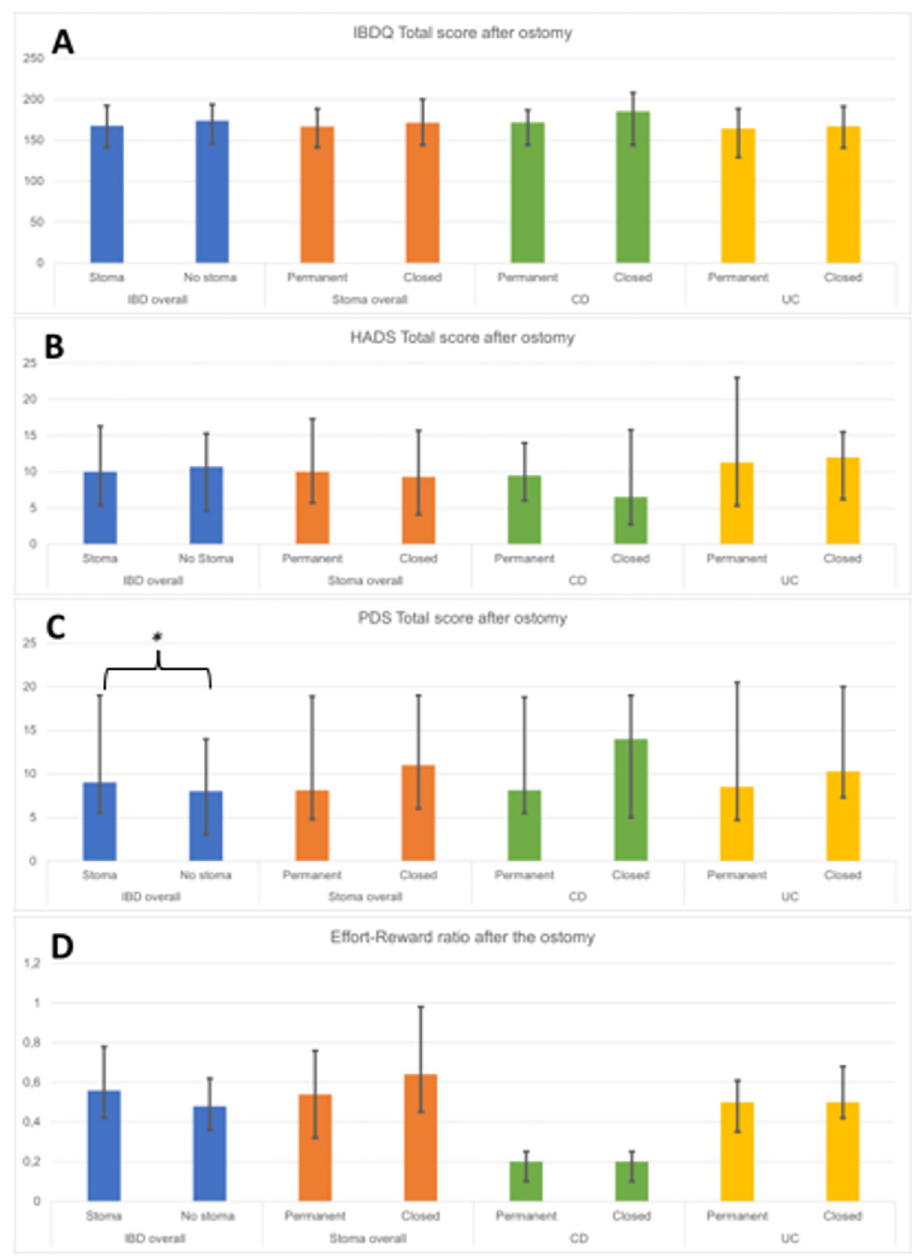
Fig 3. Comparison of different psychological scores to assess wellbeing of IBD patients. A) Comparison of median and minimal and maximal scores of Inflammatory Bowel Disease Quality of Life Questionnaire Total Score (IBDQ Total Score) in different patient groups as an indicator of health related quality of life. B) Comparison of median and minimal and maximal scores of Hospital Anxiety and Depression Scale (HADS) Total Score in different patient groups as an indicator of anxiety. C) Comparison of median and minimal and maximal scores of Posttraumatic Diagnostic Scale (PDS) Total Score in different patient groups as an indicator of Post-Traumatic Stress Disorder. D) Comparison of median and minimal and maximal scores of Effort-Reward Ratio in different patient